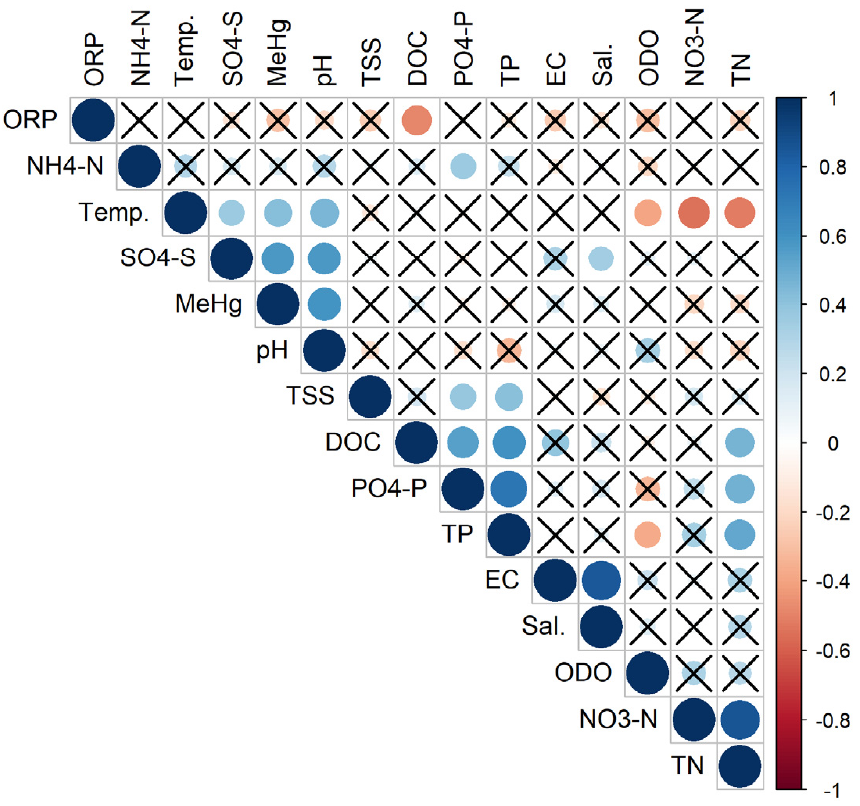
Figure 4. Spearman’s correlations between water physico-chemical parameters. Positive correlations are displayed in blue and negative correlations in red. Colour intensity and the size of the circle are proportional to the correlation coefficients. In the right side of the correlogram, the legend colour shows the correlation coefficients and the corresponding colours. Correlations with p > 0.05 are considered as insignificant (crosses are added). DOC—dissolved organic carbon, EC—electrical conductivity, ODO—optical dissolved oxygen, ORP—oxidation-reduction potential, Sal.—salinity, TN—total nitrogen, TP—total phosphorus, TSS—total